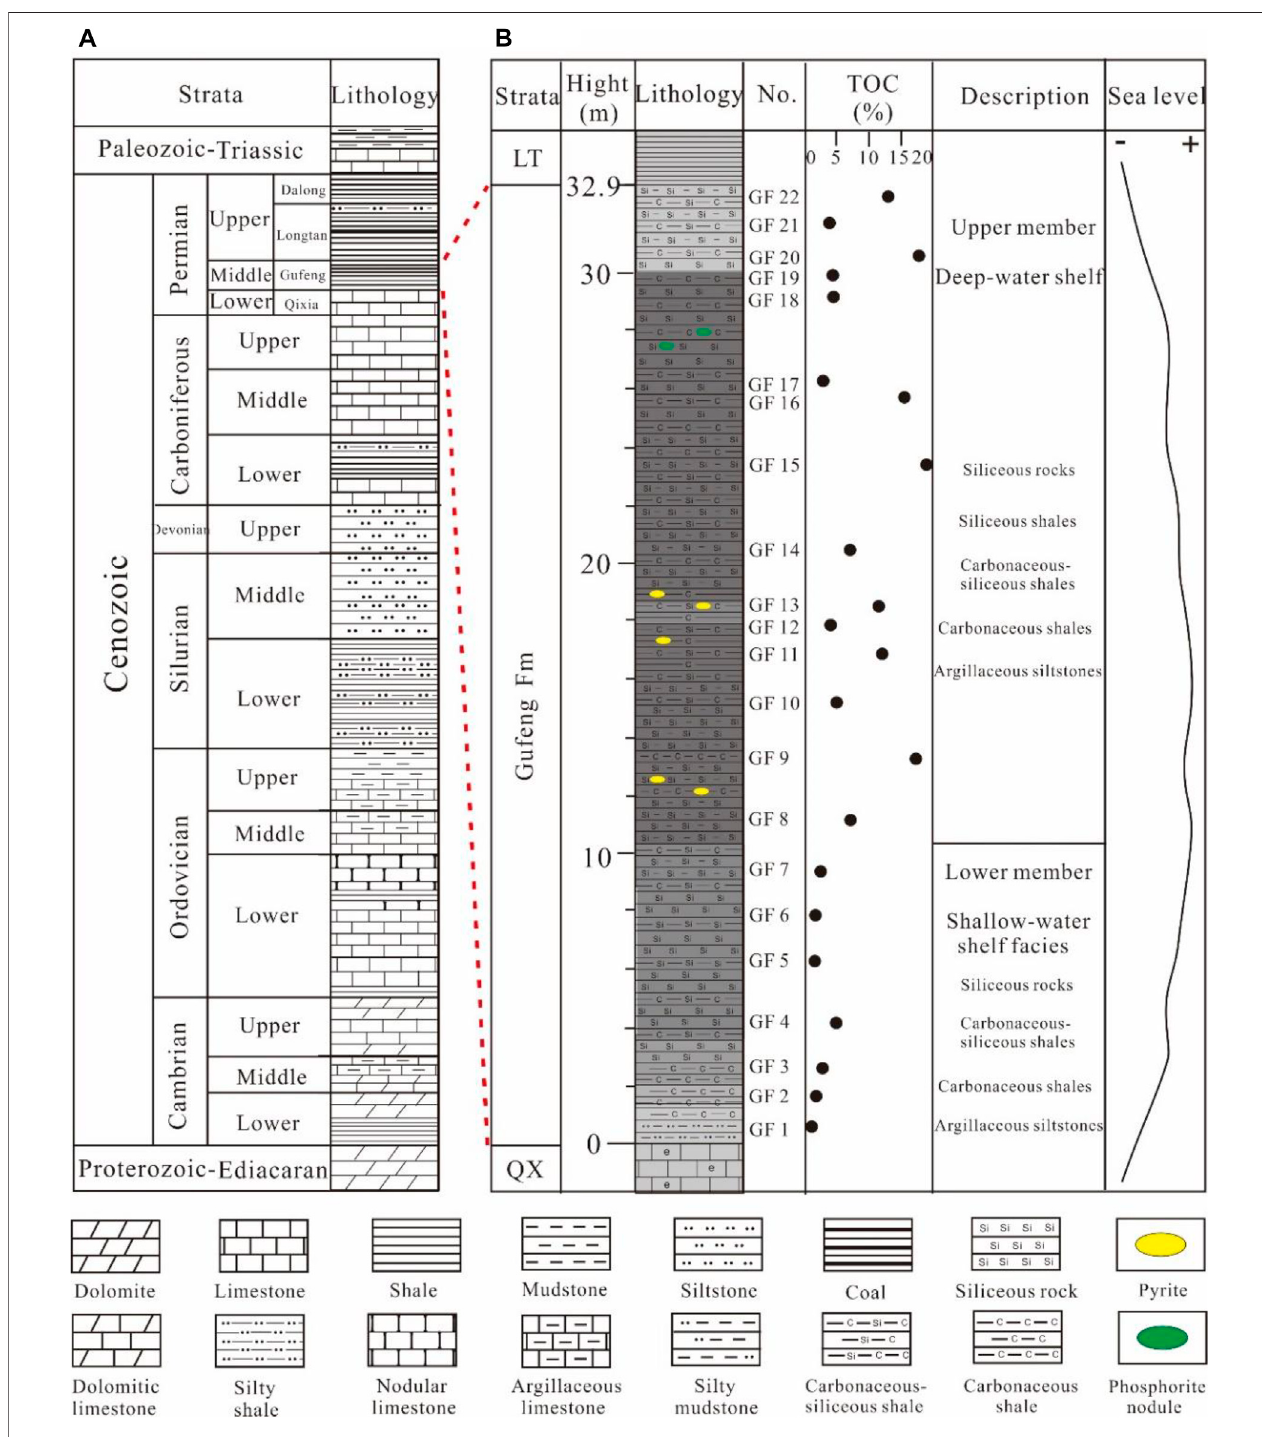
FIGURE2| Stratigraphiclog (A) intheLowerYangtzeareaandthestratigraphiccolumn (B) oftheGufengFormationatthePutaolingsection.QX,QixiaFormation; LT, Longtan Formation.